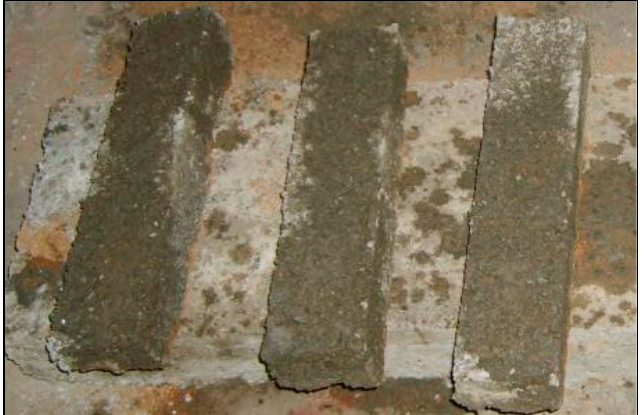
Figure 6. The flexural strength specimens.